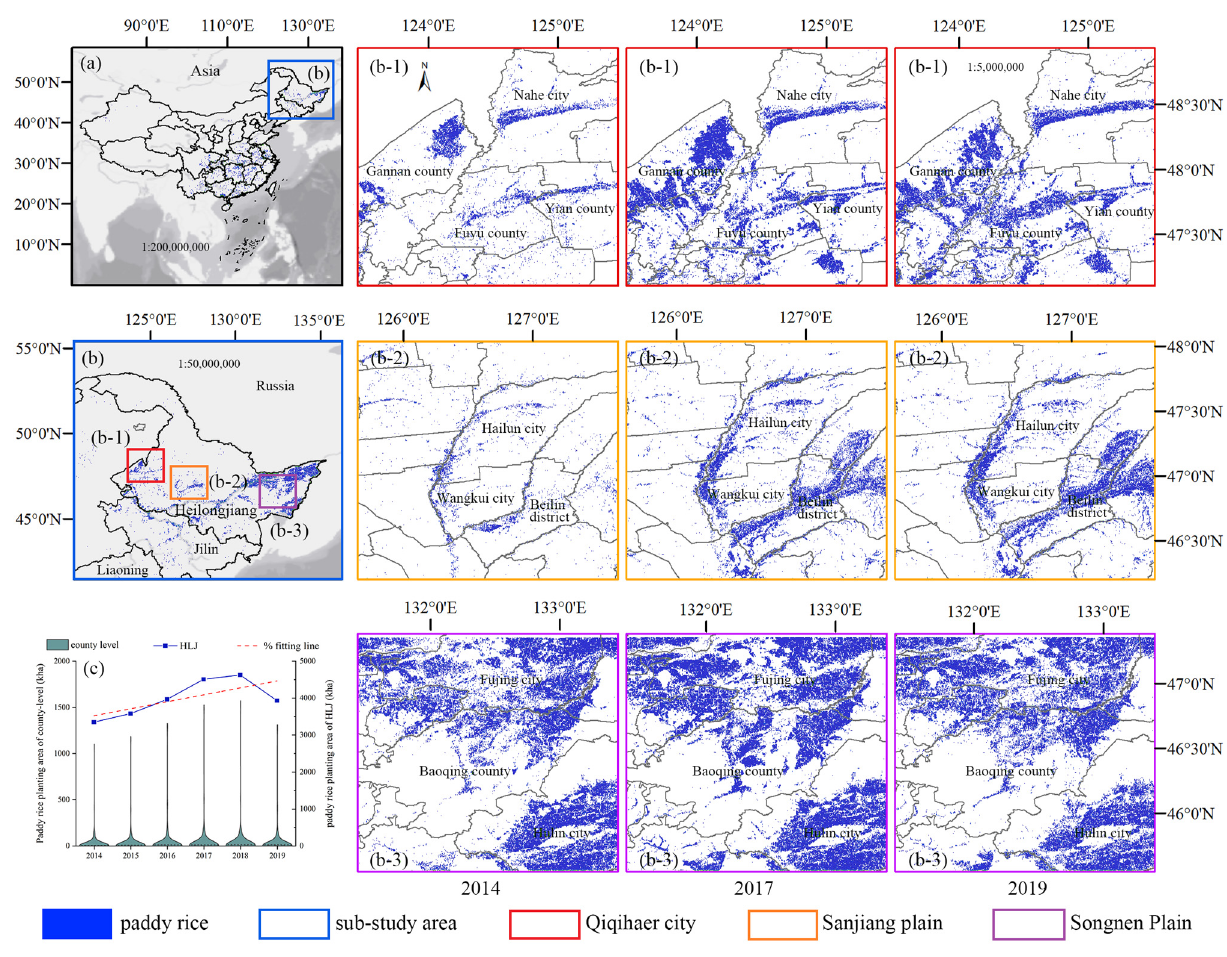
Figure 11. Spatiotemporal patterns of paddy rice in the sub-study area (Heilongjiang province, HLJ) from 2014 to 2019: ( a , b ) spatial distribution of paddy rice of study area (China) and sub-study area (HLJ) in 2019, respectively; ( c ) paddy rice planting area of HLJ at prefectural level. Magnification of figures in map ( b ) shows the remarkable expansion area of paddy rice in the HMaps of regional cropping intensity for paddy